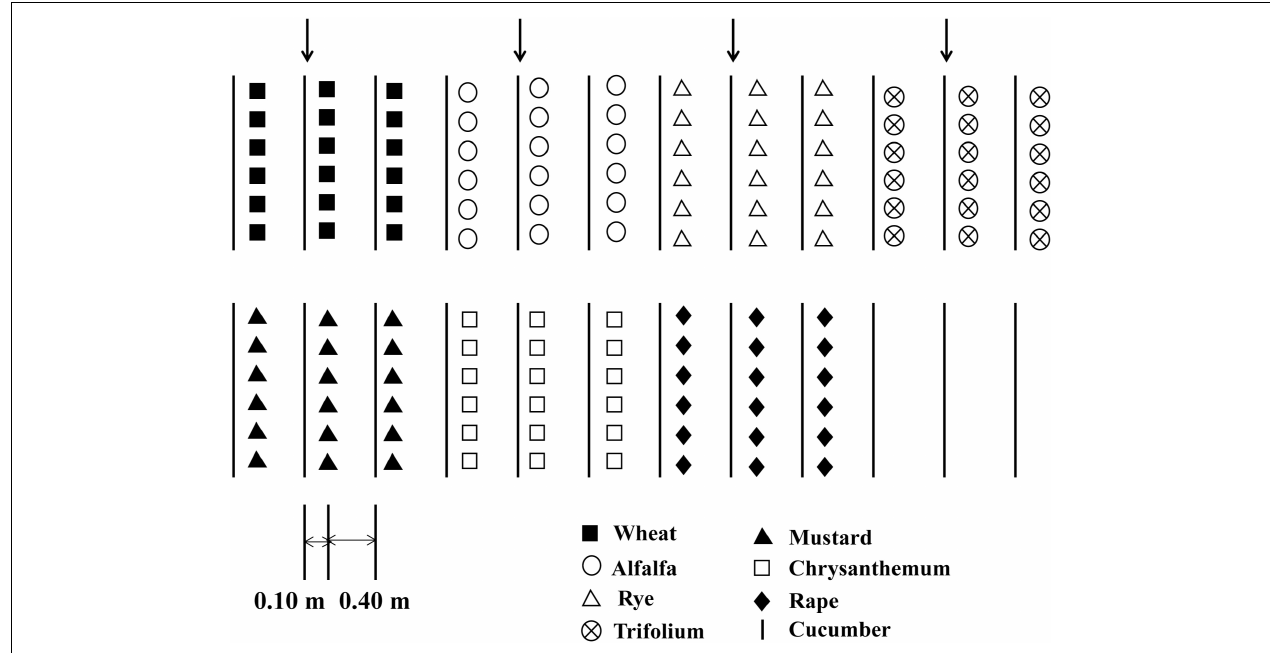
FIGURE 1 | Diagram showing different intercropping systems and the cucumber monoculture system in the greenhouse